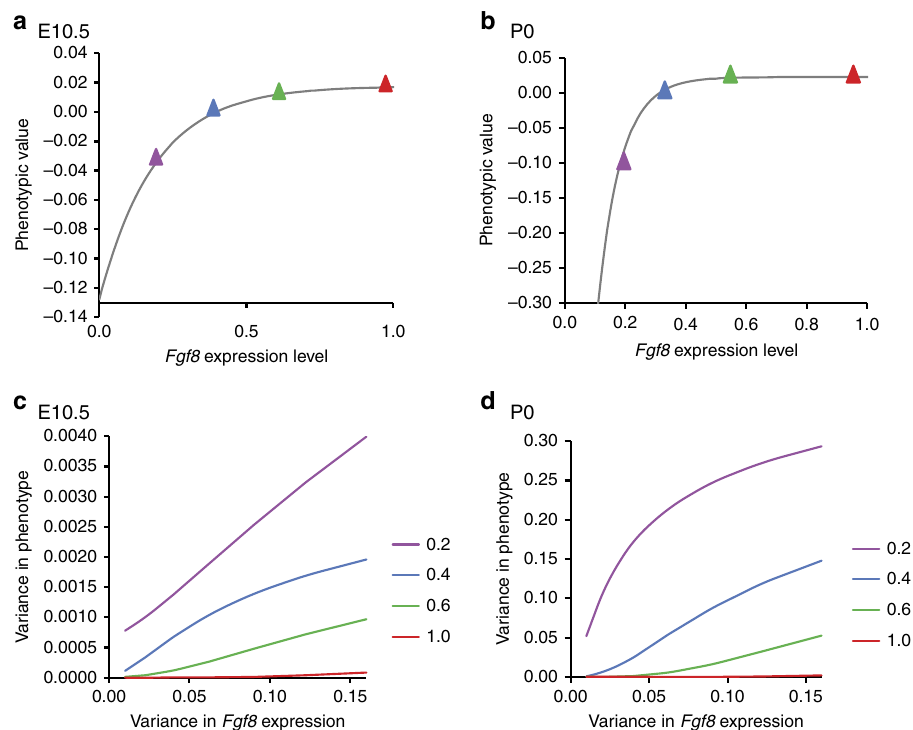
Fig. 4 Mathematical modeling of phenotypic variance. a , b Fitting the shape data (regression residuals) to a nonlinear, von Bertalanffy growth curve. Colored dots highlight the location on curves of four gene expression values that are modeled in b , c . Least-squares regression models the curve as z = 0.01765 − (0.01765 – ( − 0.12787))e ( − 5.3003* x ) at E10.5 (A) and z = 0.0288 – (0.0288 – ( − 1.333))e ( − 13.049* x ) at P0. c , d Predicted relationship between the variance of Fgf8 expression and phenotypic variance at four different levels of Fgf8 expression. Expression levels were not extrapolated below zero. This led to the use of truncated normal distributions for expression variance and is responsible for the nonlinearities in c ,